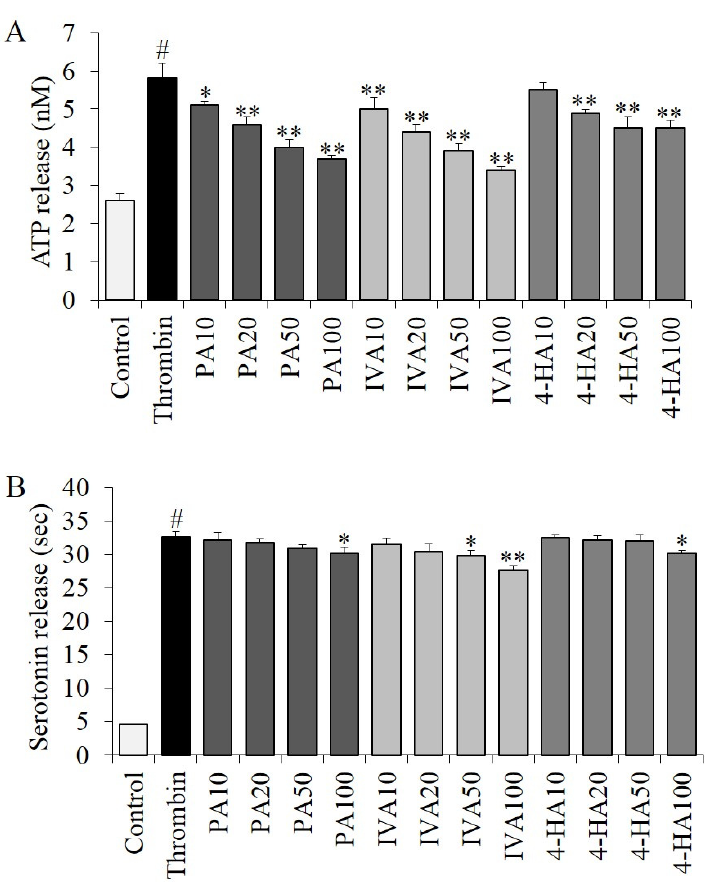
Figure 7. Effect of PA, IVA, and 4-HA on granule secretion. Aliquots of washed platelets pre-treated with or without the compounds for 5 min were stimulated with 0.25 U/mL thrombin at 37 °C for 5 min. After stimulation, the platelets were centrifuged, and the supernatants were collected. Using these supernatants, ATP ( A ) or serotonin ( B ) release was determined according to the manufacturer’s instructions. Each value is the mean ± SD of triplicate measurements. # p < 0.01, compared to each control groups. * p < 0.05 and ** p < 0.01, compared to only thrombin-treated control groups. Thrombin, thrombin treated only; PA10-100, 10–100 μg of PA treated; IVA10-100, 10–100 μg of IVA treated; 4-HA10-100, 10–100 μg of 4-HA treated.